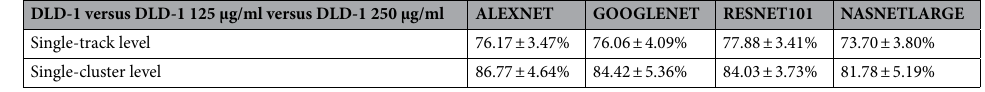
Table 4. Accuracy values of classification using four deep learning networks and SVM classifier.